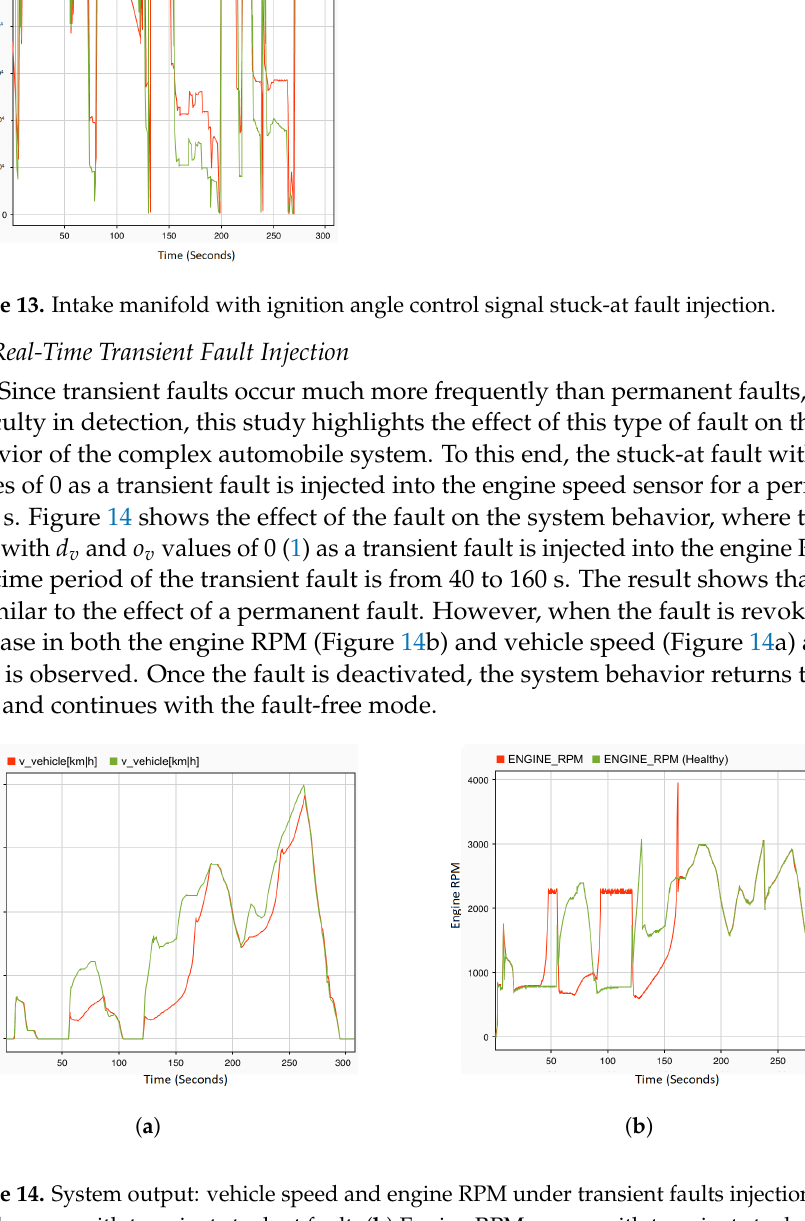
Figure 14. System output: vehicle speed and engine RPM under transient faults injection. ( a ) Vehicle speed sensor with transient stuck-at fault. ( b ) Engine RPM sensor with transient stuck-at